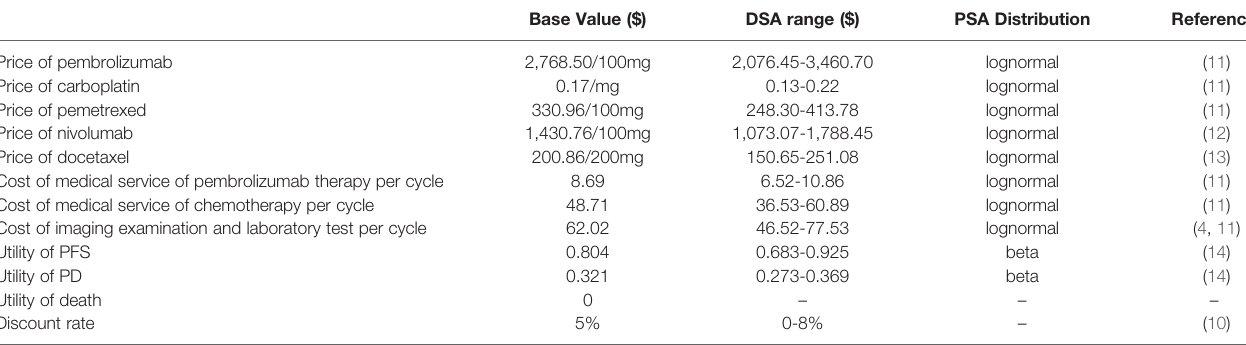
TABLE 1 | Parameters ’ value in the partitioned survival